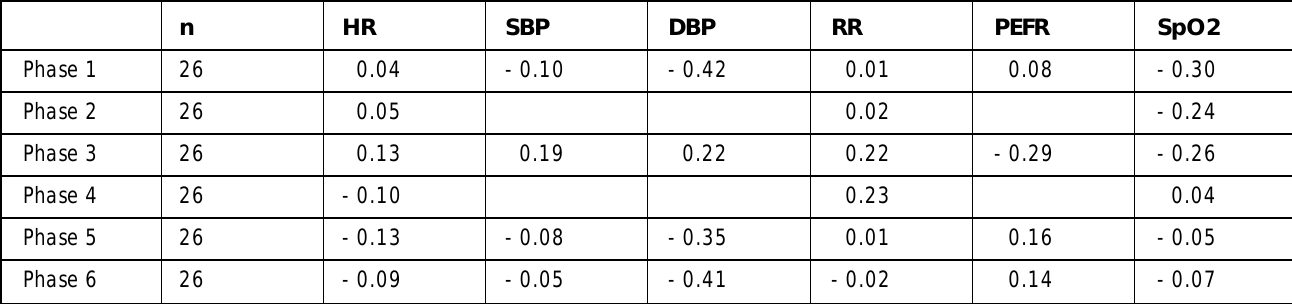
Table 1: Pearson’s correlation coefficient for phase one to six.